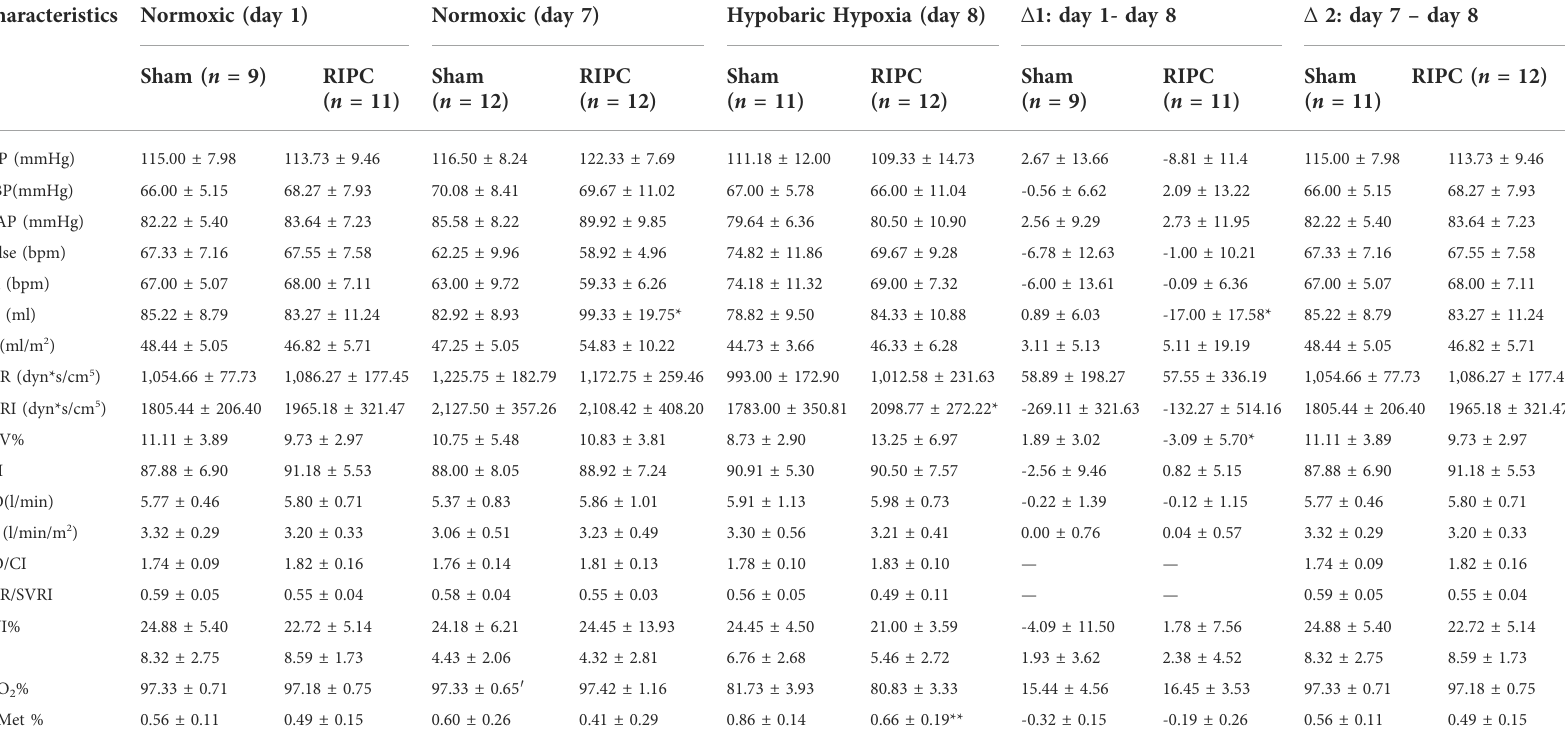
TABLE 2 Variation of basal physiological variables. Characteristics Normoxic (day